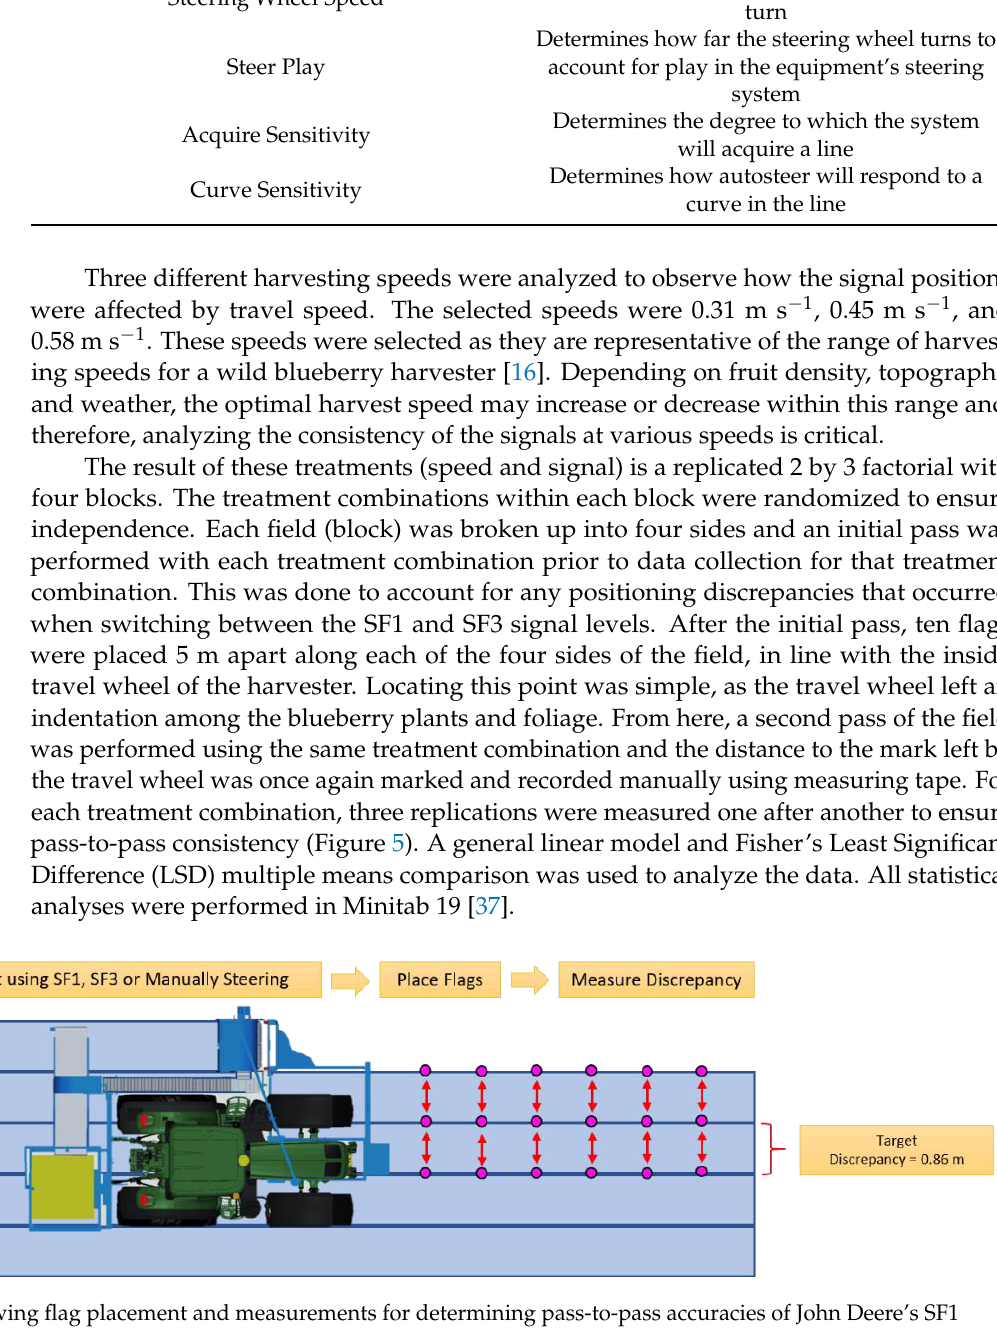
Table 3. List of available settings and their function within Auto-Trac 300.